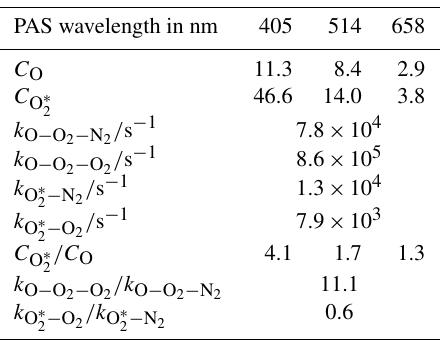
Table 1. Summary of the best fit parameters for the PAS sensitivity model described in the main